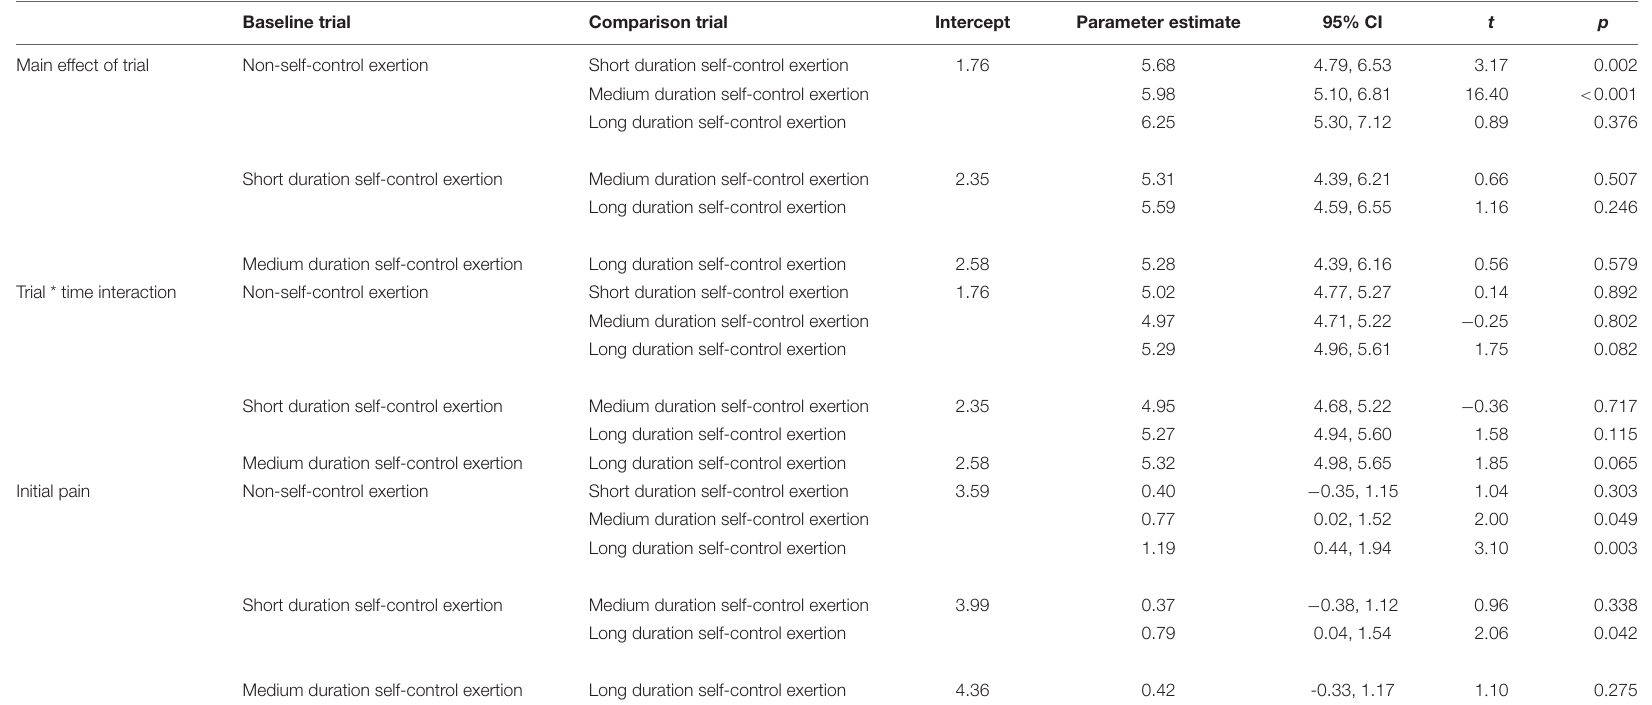
TABLE 1 | Results of the multilevel models conducted for perceptions of